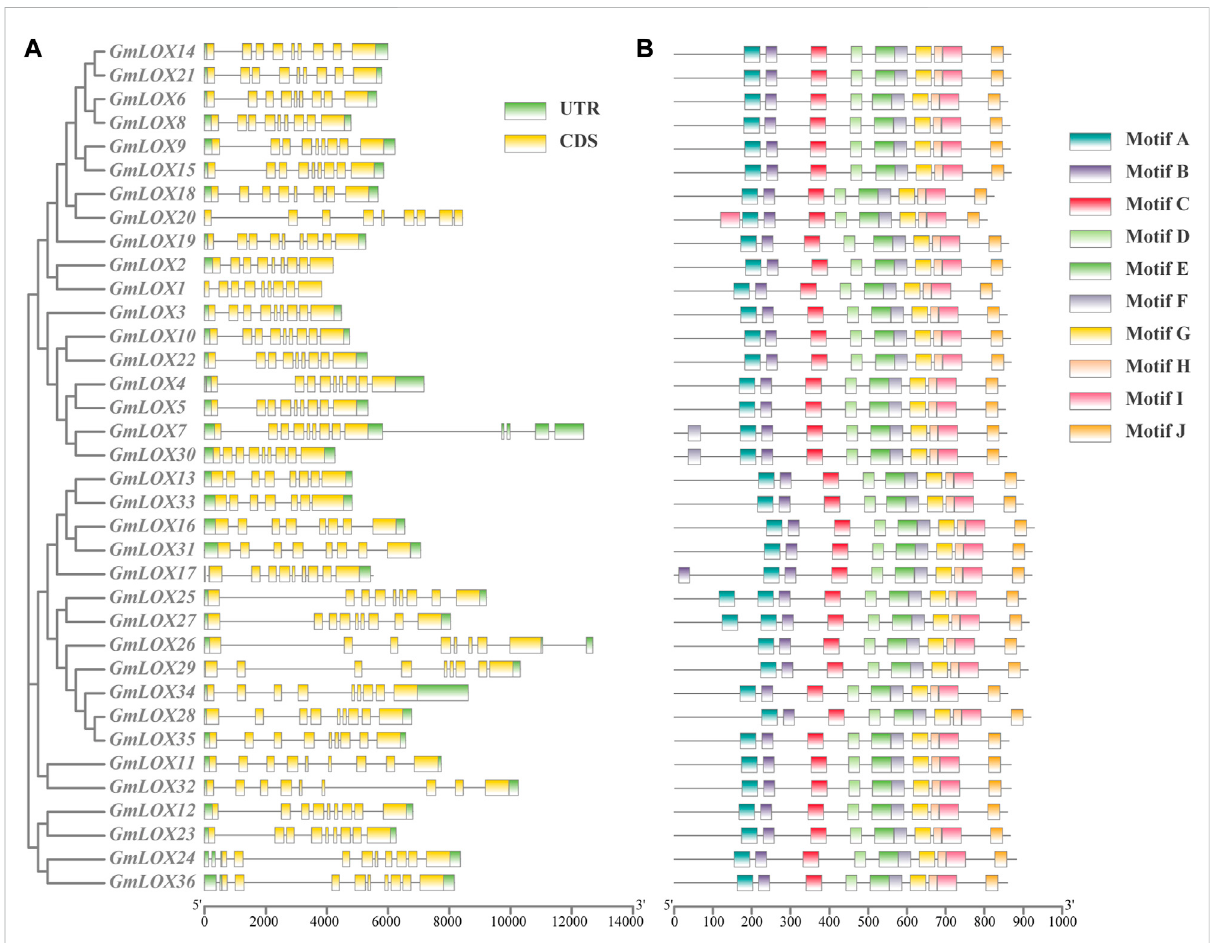
FIGURE 4 Genestructureanalysisandconservedmotifpredictionof GmLOX genesinZhonghuang13Note: (A) Theresultofgenestructureanalysiswitha cluster analysis tree of polypeptide sequences by the ML method. CDS (coding sequence) regions are marked with yellow boxes, UTR (untranslated region) with green boxes and intron with black lines. (B) The motifs represented by different coloured boxes refer to the legend on the right. The scales at the bottom are used to measure the length of the